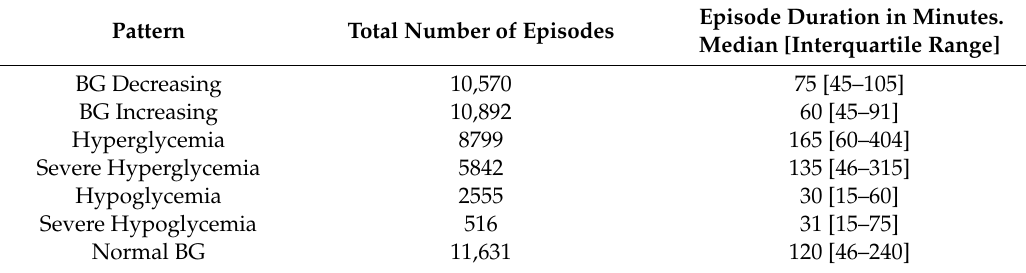
Table 4. Snapshot on the patterns found in the dataset.